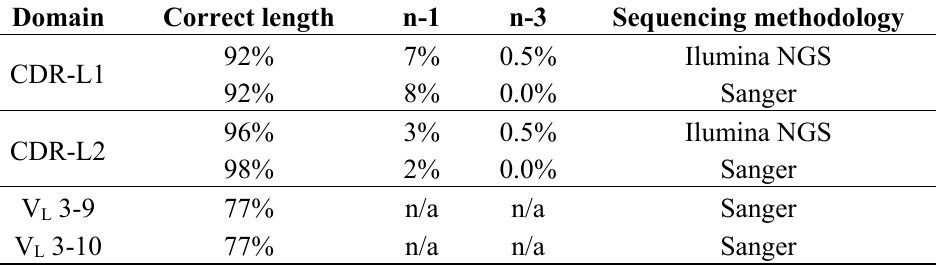
Table 1. Length accuracy of synthetic scFv loops and domains. Light chain CDR loops were analysed by Illumina Miseq sequencing (n = 351021 for CDR-L1 and 345614 for CDR-L2) and the results verified by Sanger sequencing (n = 102). CDR-L1 and CDR-L2 were then combined with exemplar CDR-L3 domains encoding loop lengths of both 9 and 10 aa’s, to generate light chain libraries V L 3-9 and V L 3-10 respectively. The percentage of functional (in frame) fully-assembled light-chain V L sequences was examined by Sanger